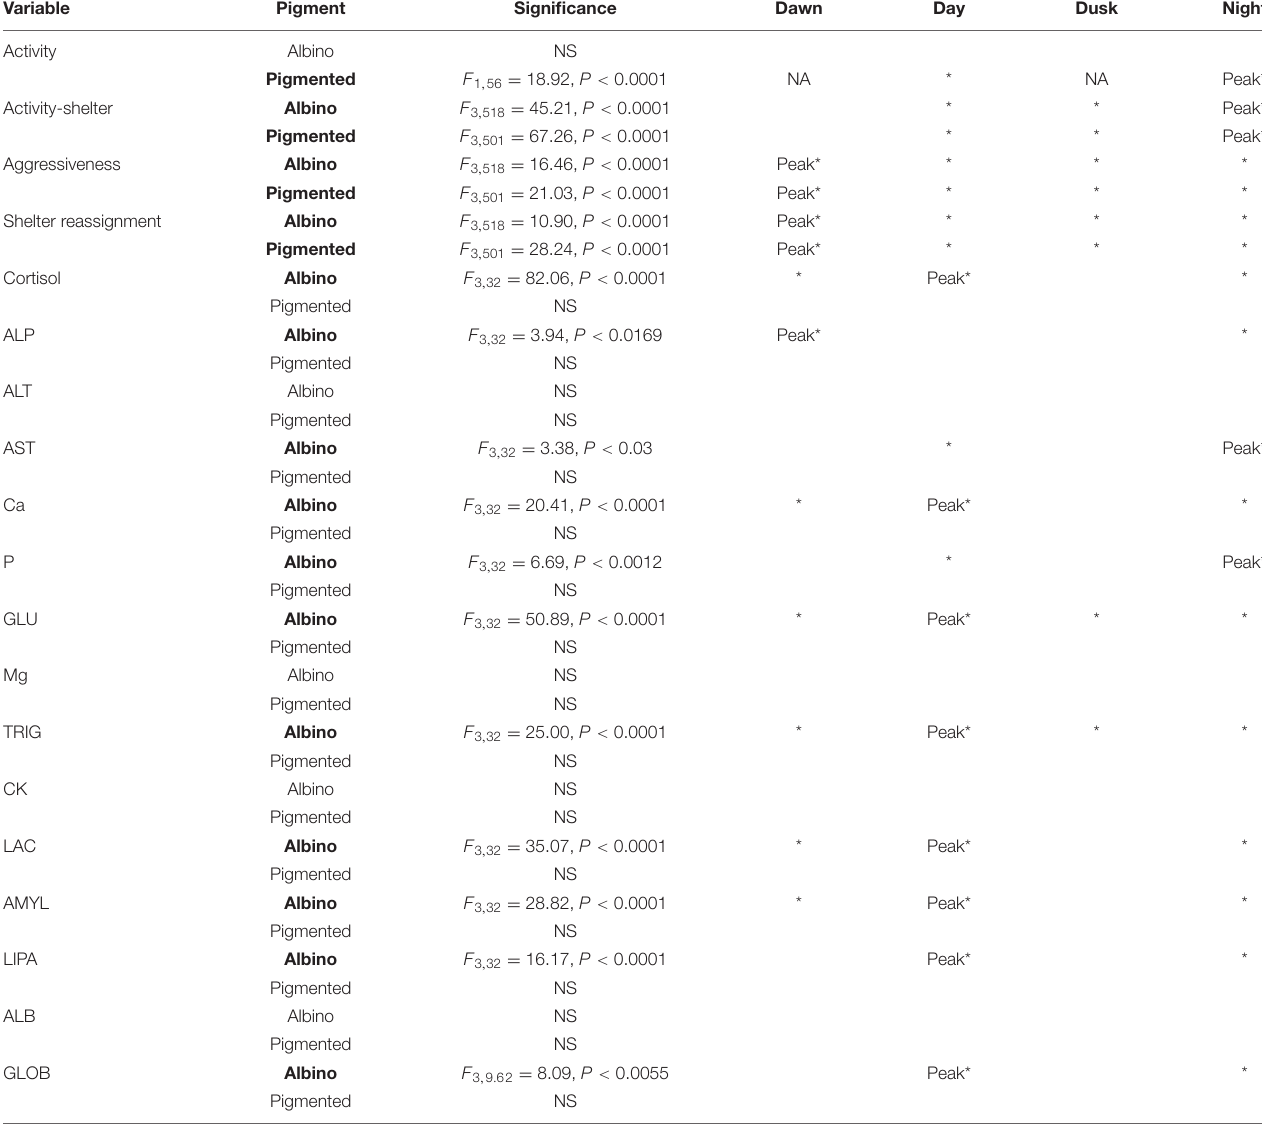
TABLE 1 | Diel rhythms of behavioral and biochemical indices.